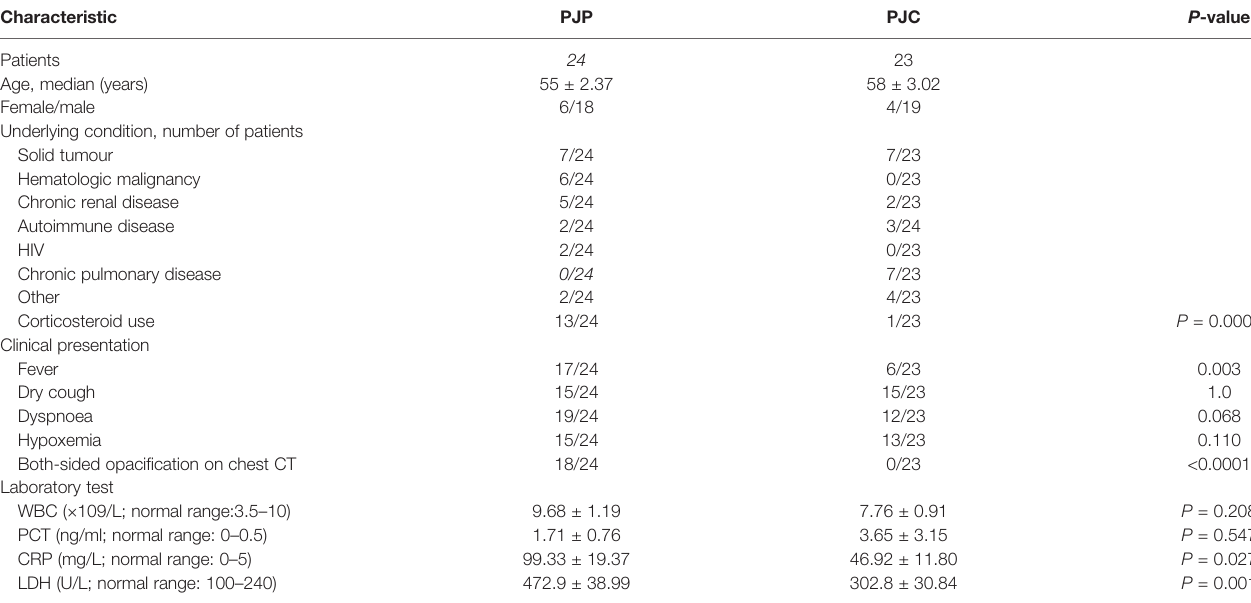
WBC, white blood cell; PCT, procalcitonin; CRP, C-reactive protein; LDH, lactate dehydrogenase; CT, computed tomography.